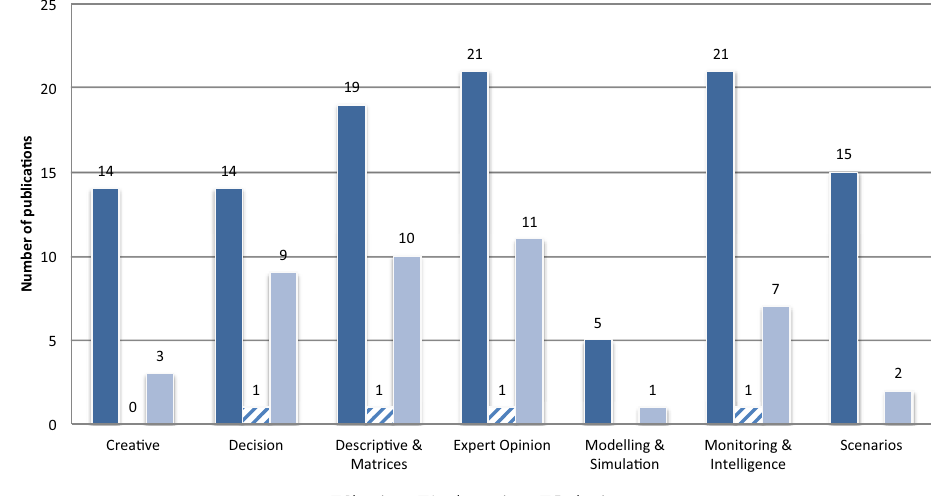
Fig. 7 Families of methods of